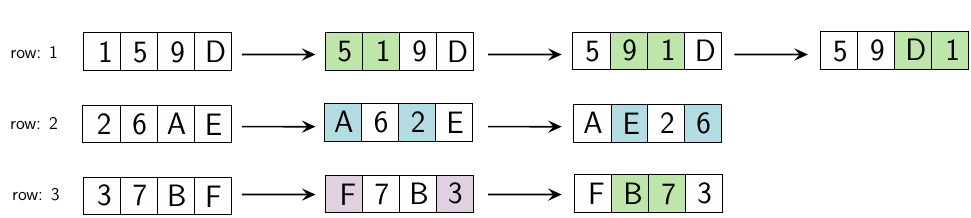
Figure 3: The transition diagram for rows 1, 2, 3; where the colored cells denote the recently modified values. Note that there are three distinct swap operations, with distance 0, 1 and 2 cells in-between.